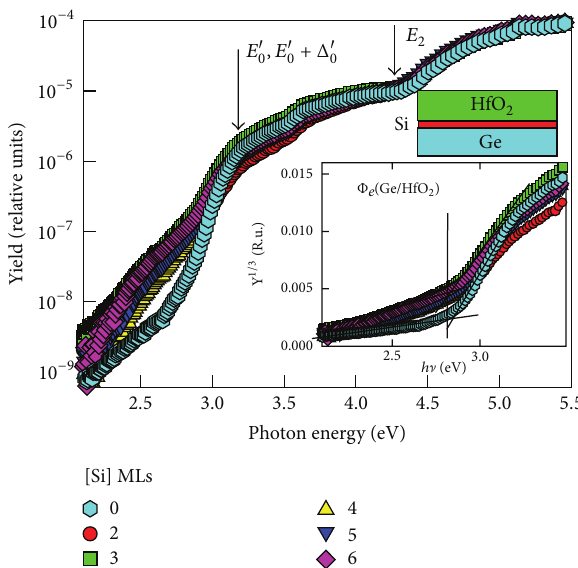
Figure 35: Semiogarithmic spectral plots of the electron IPE yield as measured in (100)Ge/Si/HfO 2 /Au samples under +1.5V bias on the Au electrode for different thicknesses (in monolayers of Si) of the inserted Si IL. The vertical lines mark the energy onsets of direct optical transitions between high symmetry points in the Brillouin zone of the Ge substrate crystal. The inset illustrates determination of the electron IPE threshold Φ 𝑒 (Ge/HfO 2 ) marked by the vertical line using 𝑌 1/3 - ℎ ] plots. Lines guide the eye.